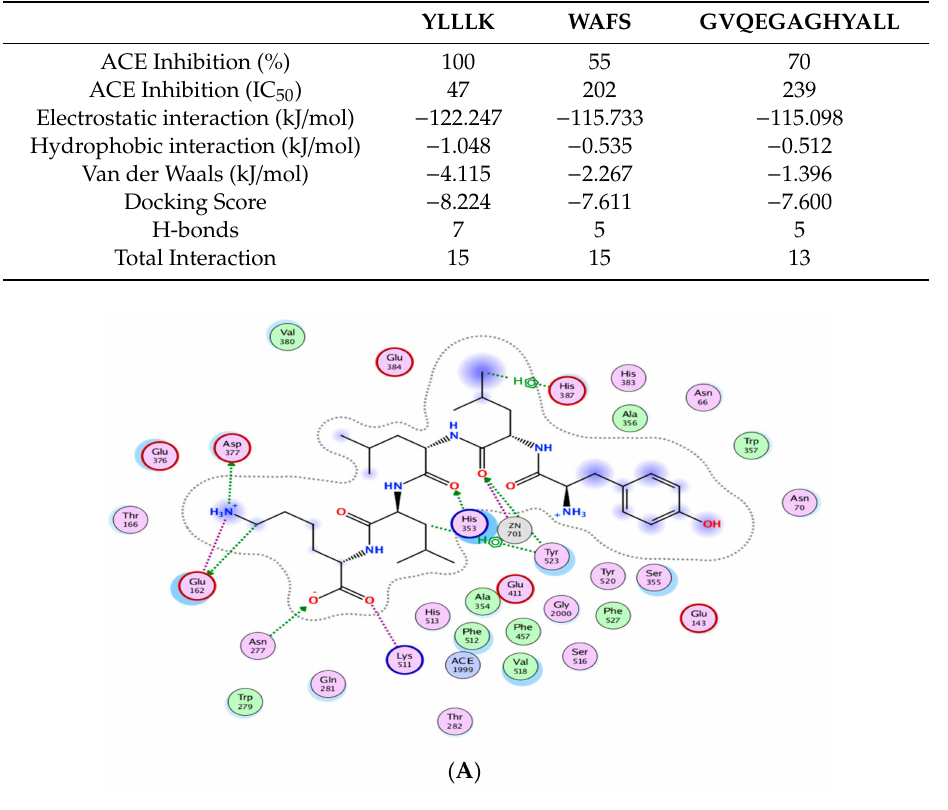
Table 5. ACE inhibitory activities and docking study characteristics of